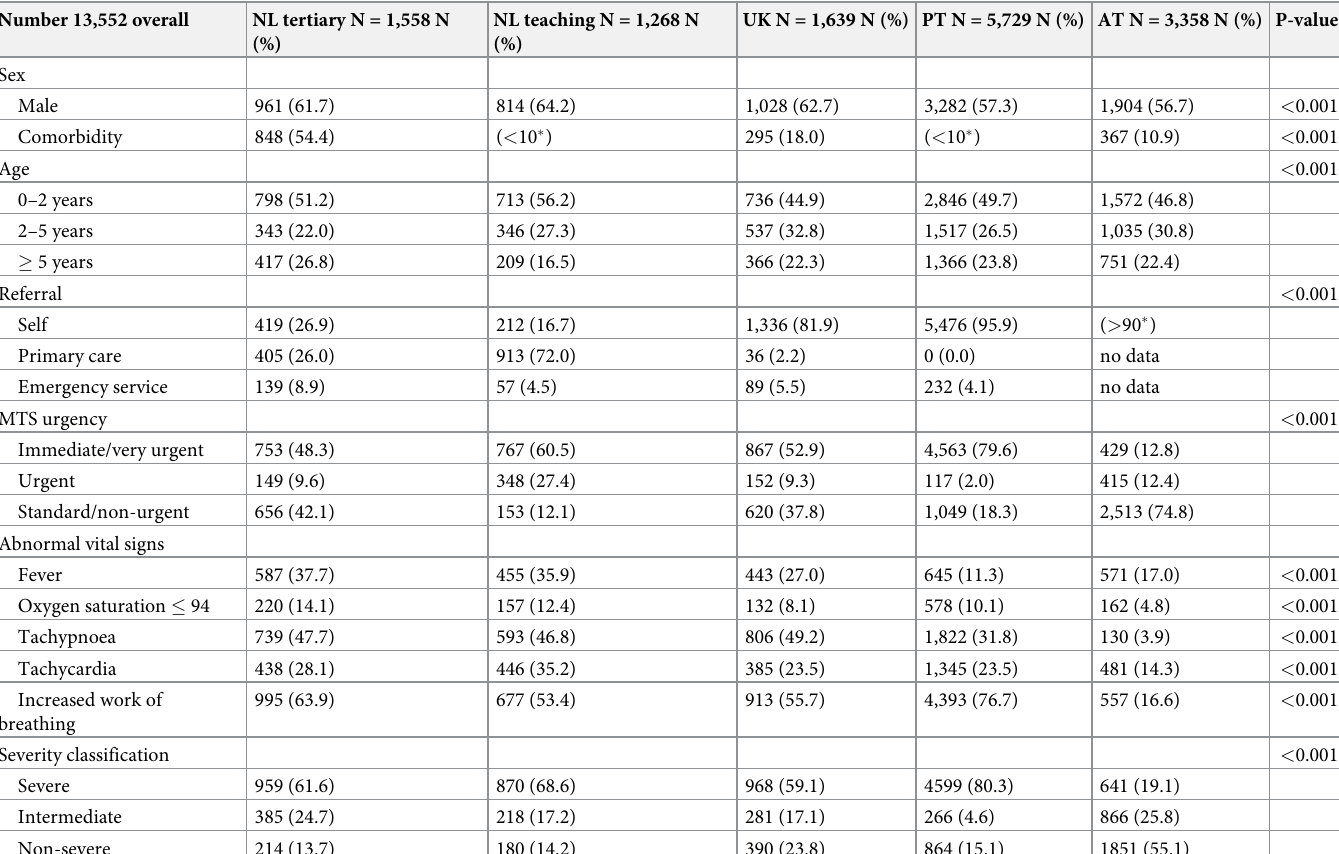
Table 1. Patient characteristics and markers of disease severity in percentage across EDs in